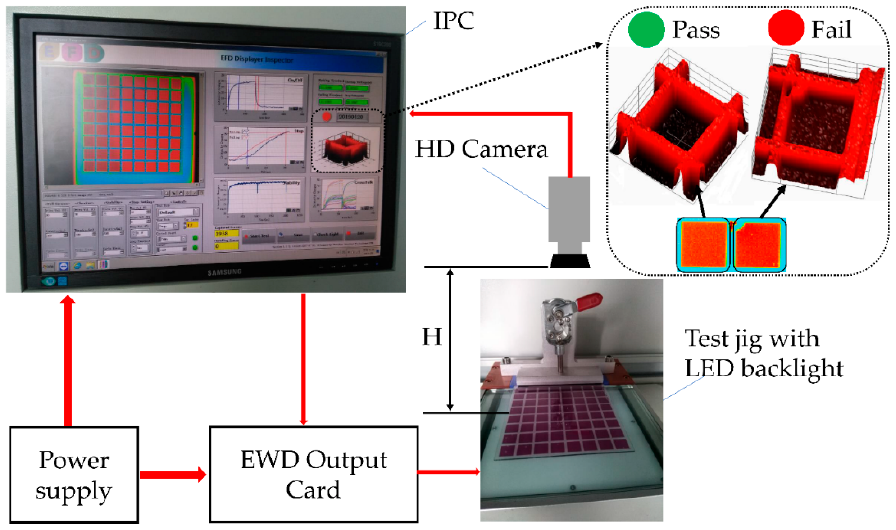
Figure 4. Schematic of the electro-fluid display inspector system for scalable testing process.